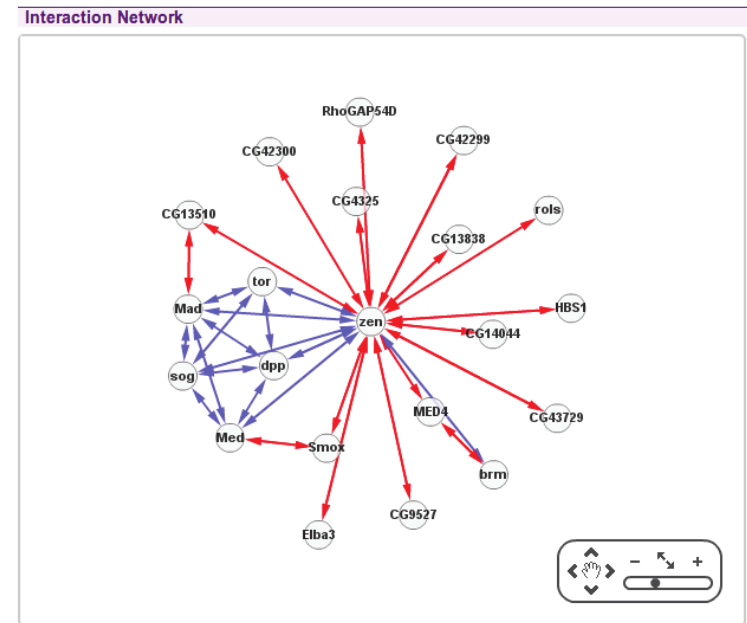
Figure 1. Using Cytoscape to display an interaction network with a force-directed